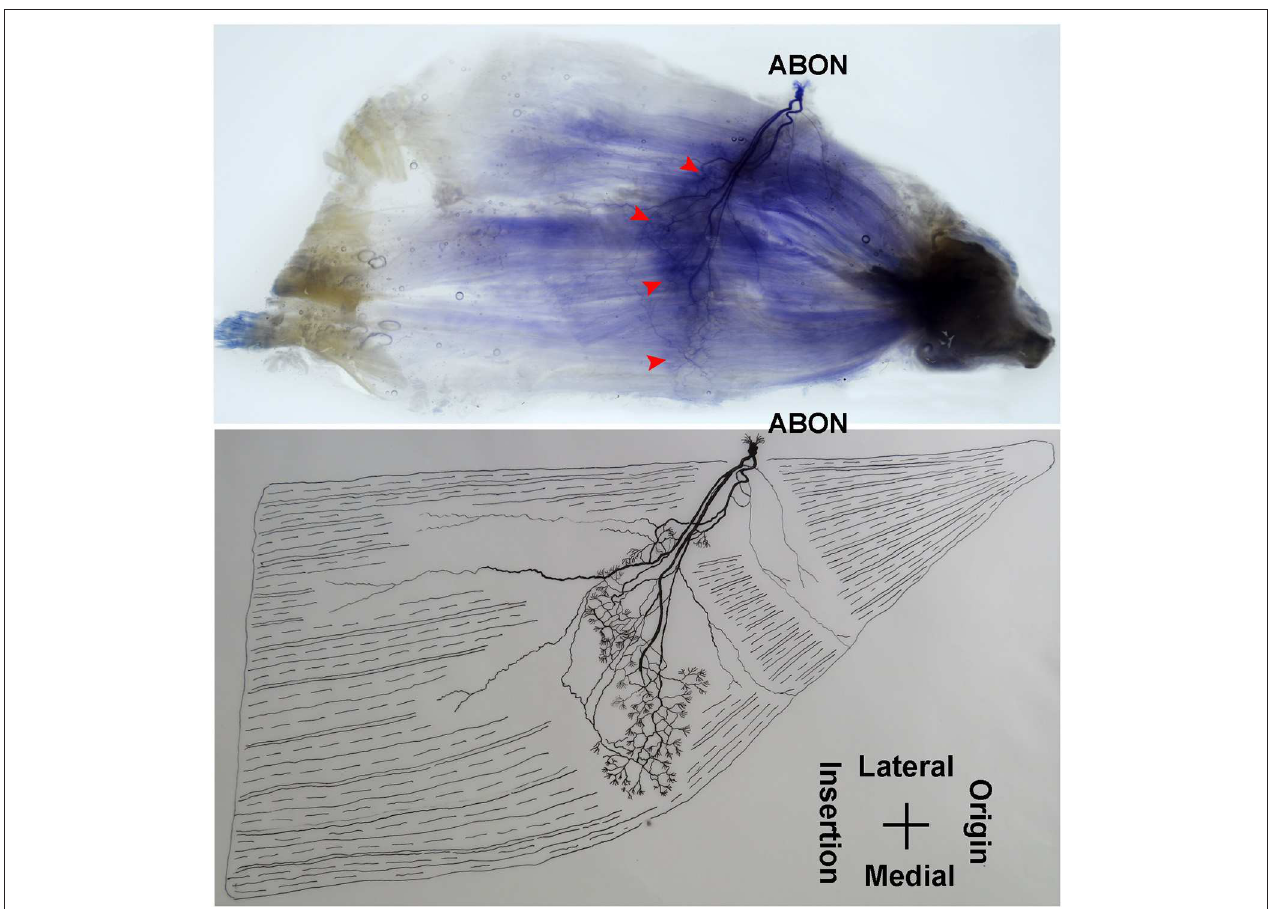
FIGURE 3 | Distribution of intramuscular nerves in the adductor brevis (right, superficial side). The arrowhead indicates the grid-like terminal nerve junctions (ABON, anterior branch of the obturator nerve).